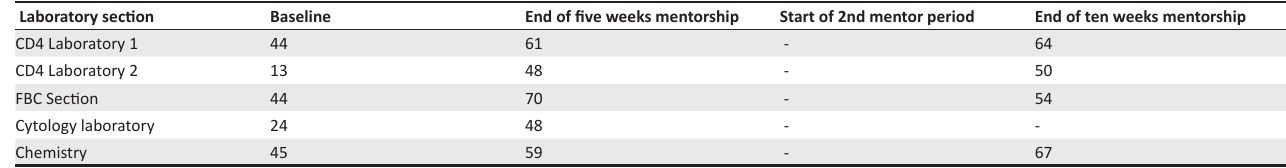
FBC, full blood count. The section-specific checklist was out of total possible marks of